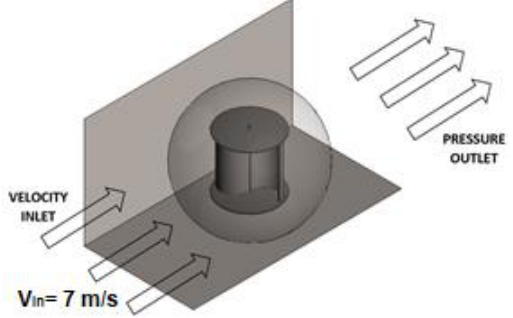
Figure 5. Boundary conditions.